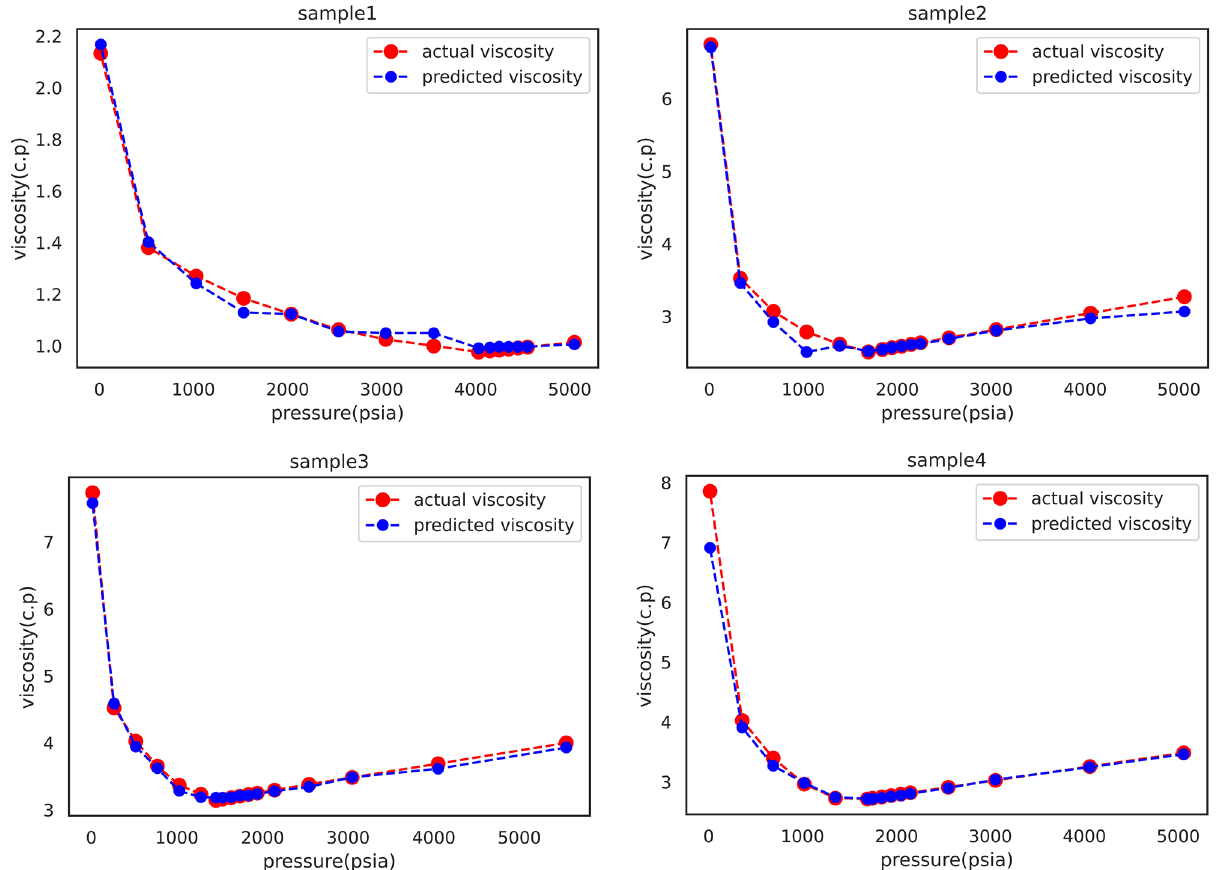
Figure 5. Graphical illustration for comparison between experimental viscosity values and the XGBoost model estimations of four Iranian oil samples at different